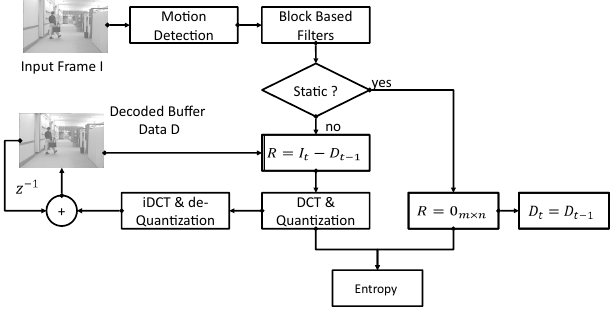
Figure 8. Proposed encoding architecture for fixed predictor from the previous decoded video frame.